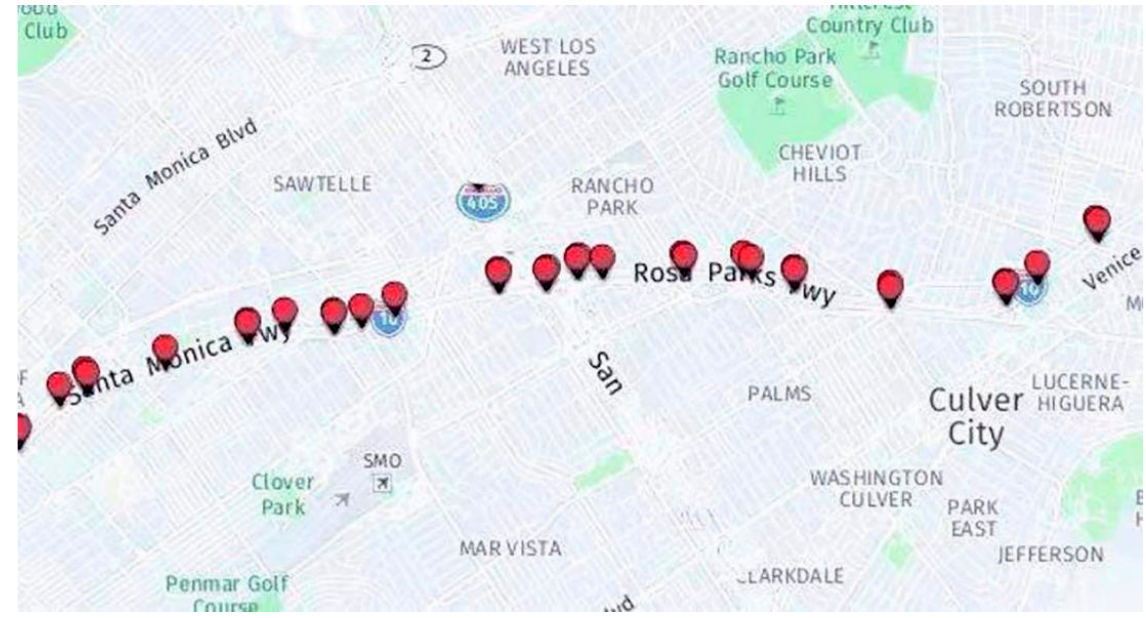
Figure 4. Detection point location map.